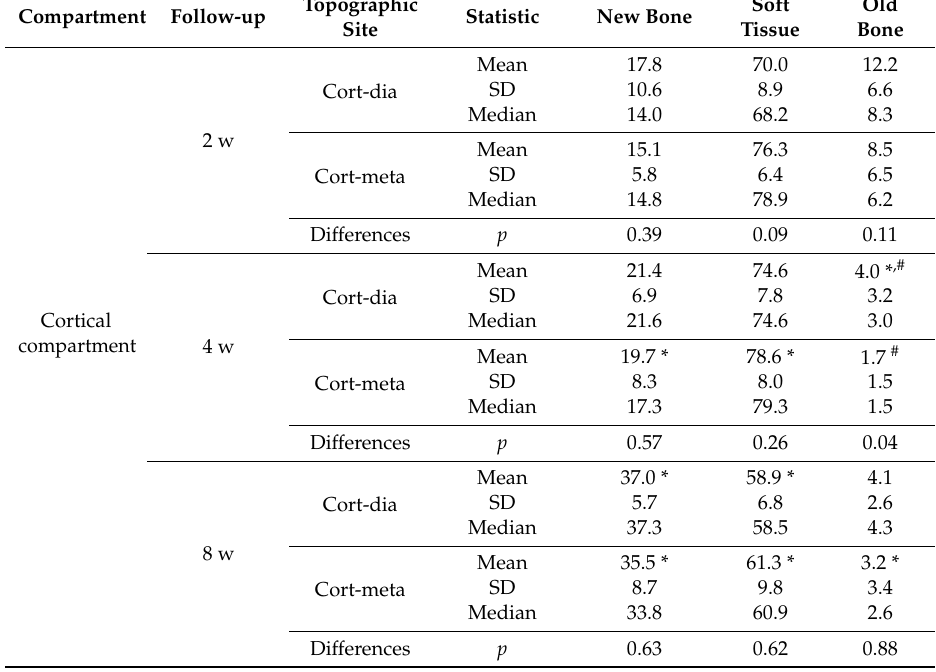
Table 1. Proportion (%) of tissue components in contact with the implant surface for either the cortical or the marrow bony compartments at the various time periods in weeks (w). n = 9 per each period of